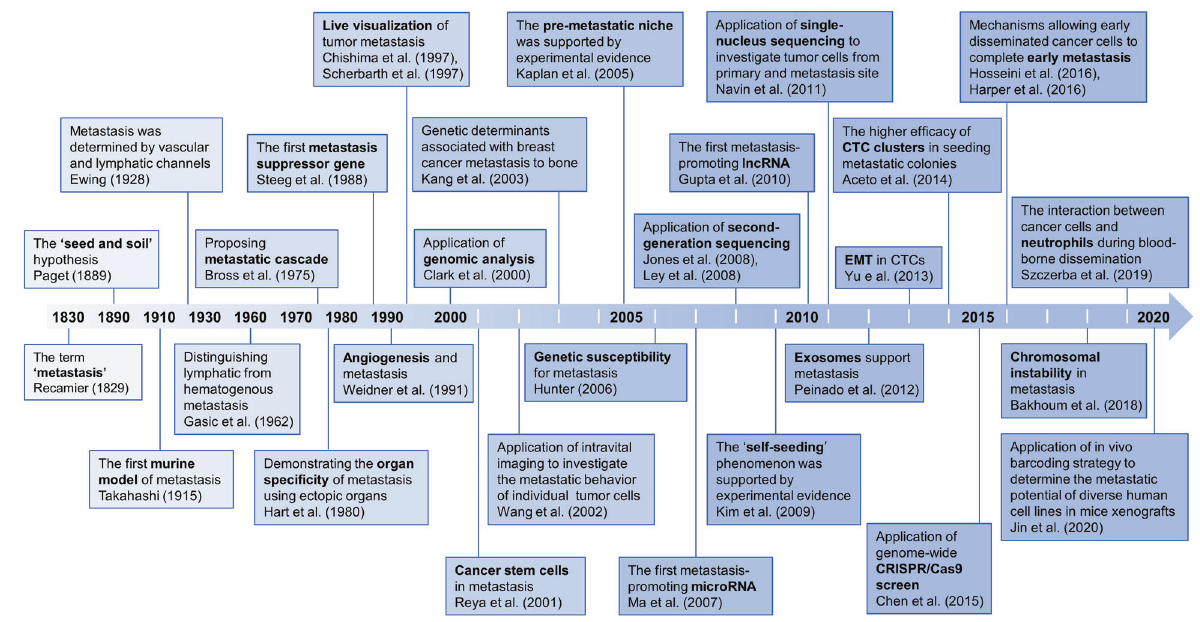
Fig. 1 The historical milestones of cancer metastasis